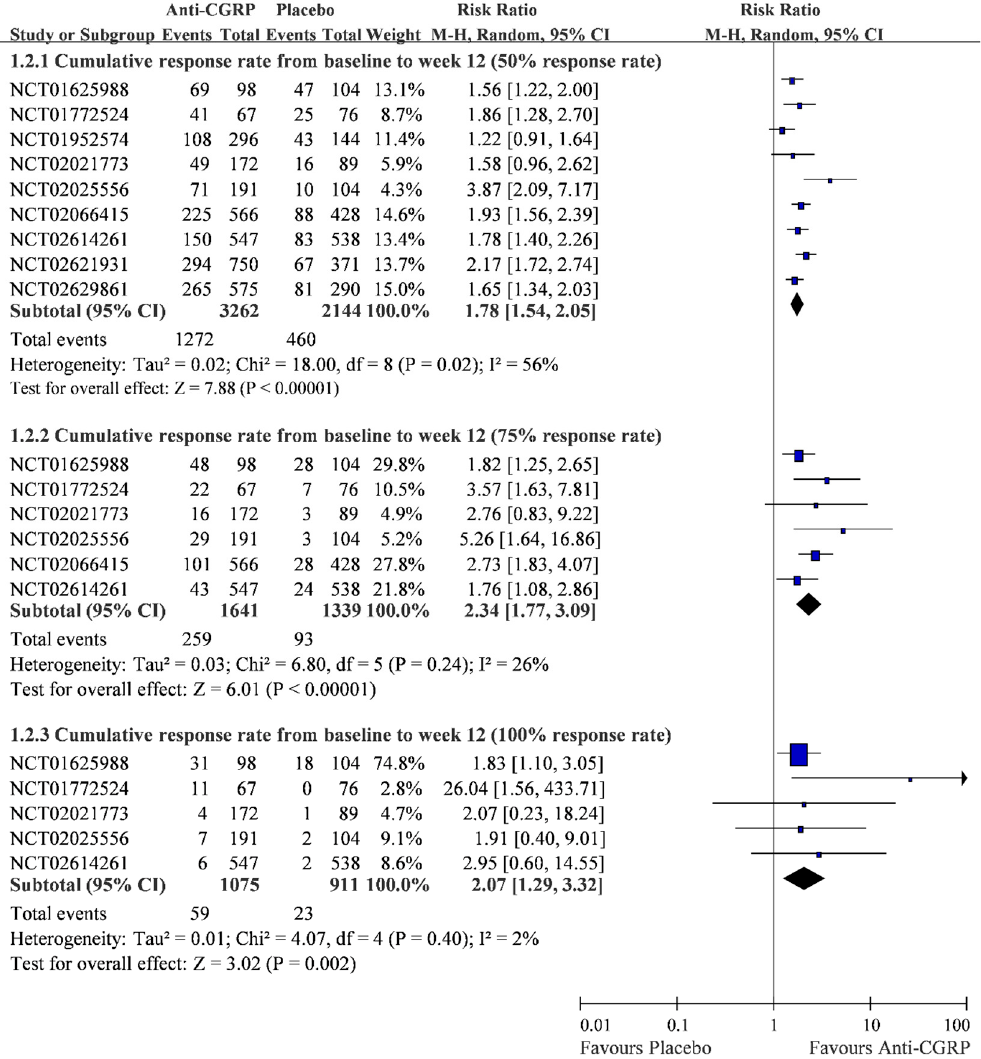
Figure 3. Cumulative response rate from the initial to the 12th month between anti-CGRP and placebo.